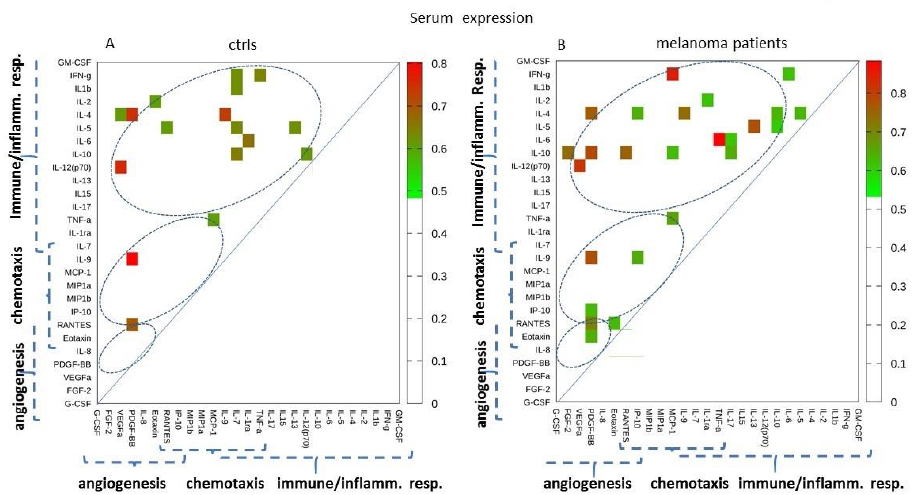
Figure 2. Correlation analysis of the serum expression values. The heatmaps in ( A , B ) show the correlation of pairs of expression values having a p -value <0.05 and Spearman’s rank coefficient >0.60, in the control and in melanoma samples, respectively.